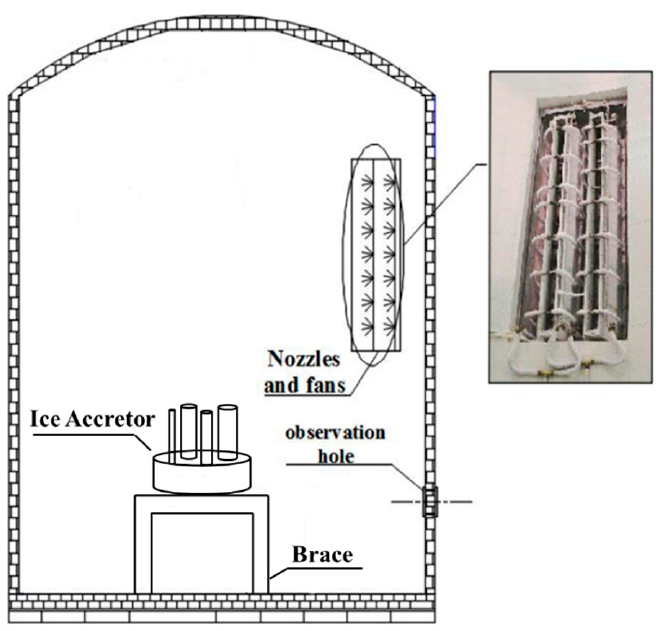
Figure 11. The layout of the experiment.